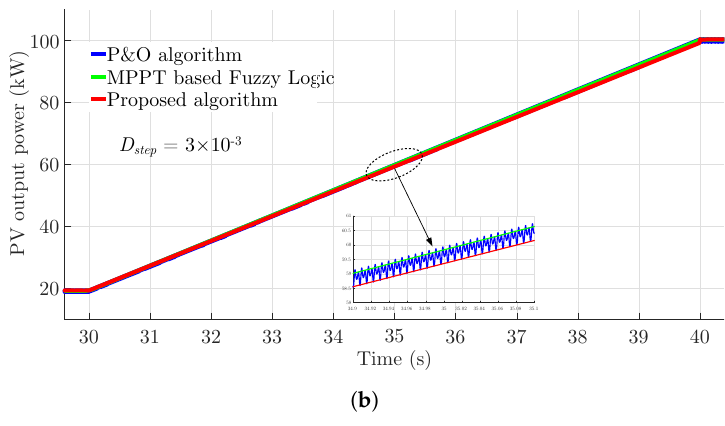
Figure 18. Comparison of the output power in the case of solar radiance increasing slowly from 200 W/m 2 to 1000 W/m 2 within 10 s: ( a ) D step = 3 × 10 − 4 ; ( b ) D step = 3 × 10 − 3